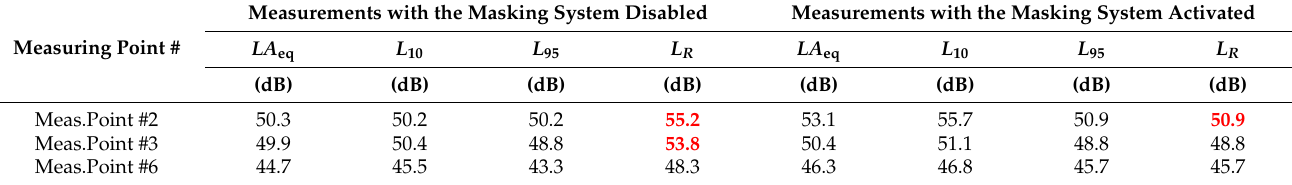
Table 3. Results of measurements of characteristic statistical descriptors. The red color indicates values that exceed the legal limit for the night period (50 dB).